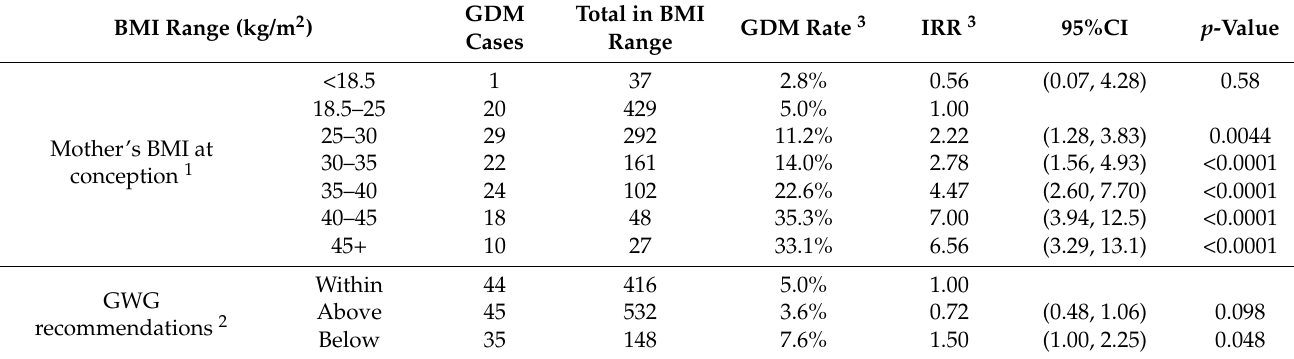
Table 4. Diagnosis of GDM in different BMI ranges and GWG categories in mothers screened for GDM during current pregnancy. BMI Range (kg/m 2 )